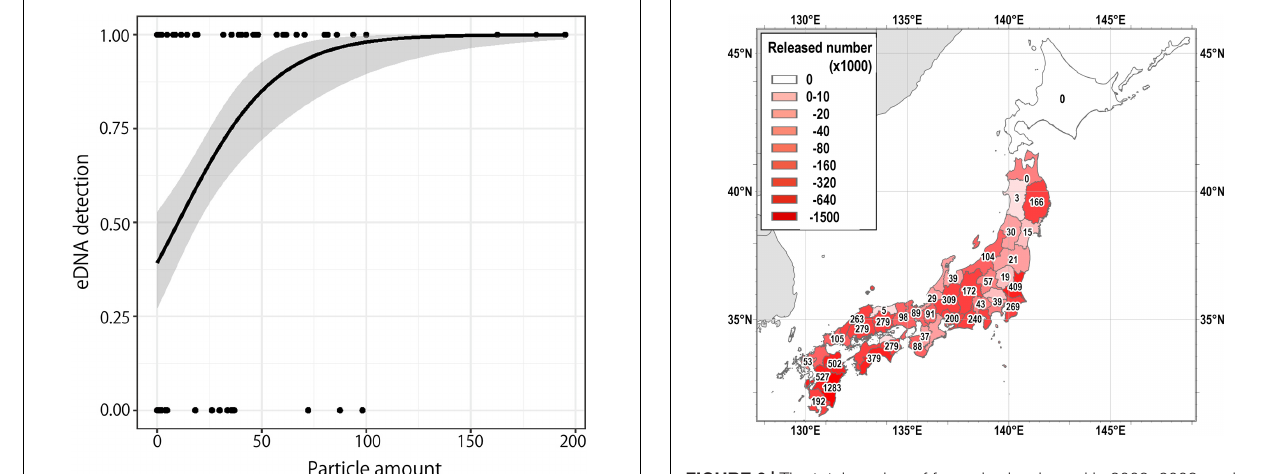
FIGURE 6 | The total number of farmed eels released in 2003, 2008, and 2013 in each prefecture by prefectural Inland Fisheries Cooperatives (Data from the Fishery Census 2003, 2008, and